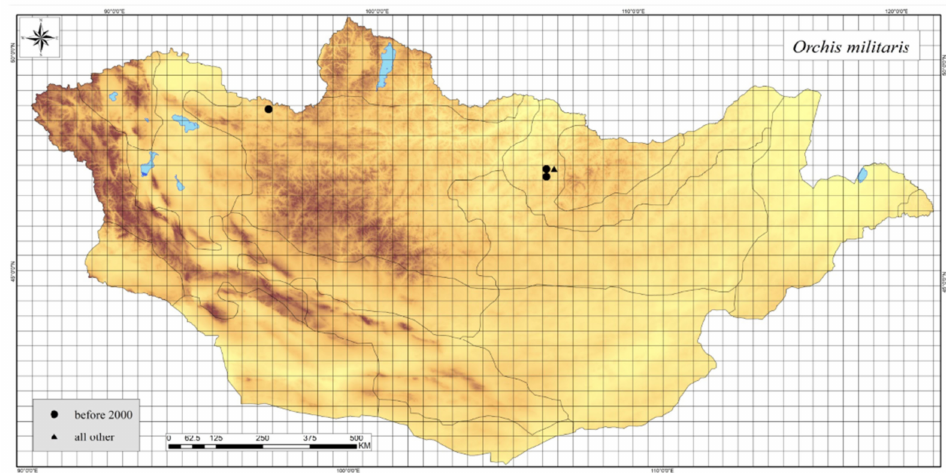
Figure A21. Distribution map of Orchis militaris in Mongolia.